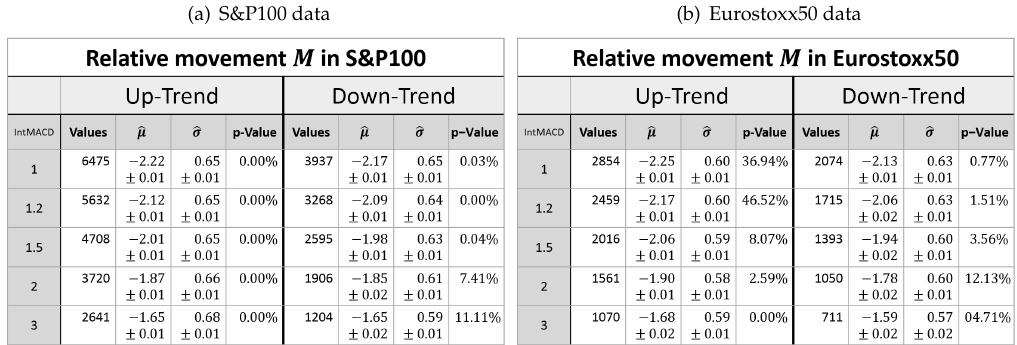
Table 6. Parameters of the log-normal fit for the relative movement in up- and down-trends. ( a ) S&P100 data. ( b ) Eurostoxx50